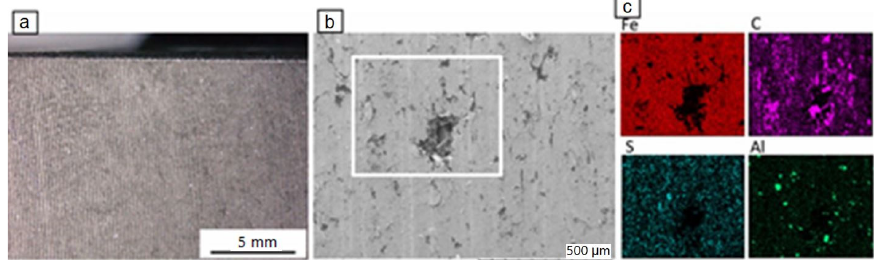
Figure 2. Light microscopy image ( a ) and BSE-SEM image of the disc ( b ), together with element mapping ( c ) of the white square in ( b ).